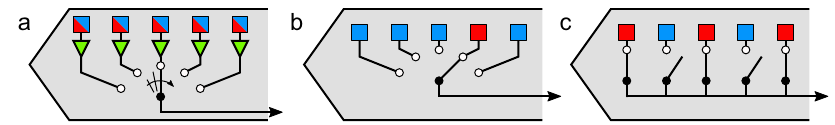
Fig. 1 Strategies for using a single wire to serve many recording sites in switchable silicon probes. a Time-division multiplexing. Rapidly cycling the selector switch allows a single wire to carry signals from many recording sites interleaved in time. Triangles represent anti-aliasing fi lters. b Static switching. A single wire connects to one of many possible recording sites through a selector switch. c Electrode pooling. Many recording sites are connected to a single wire through multiple controllable